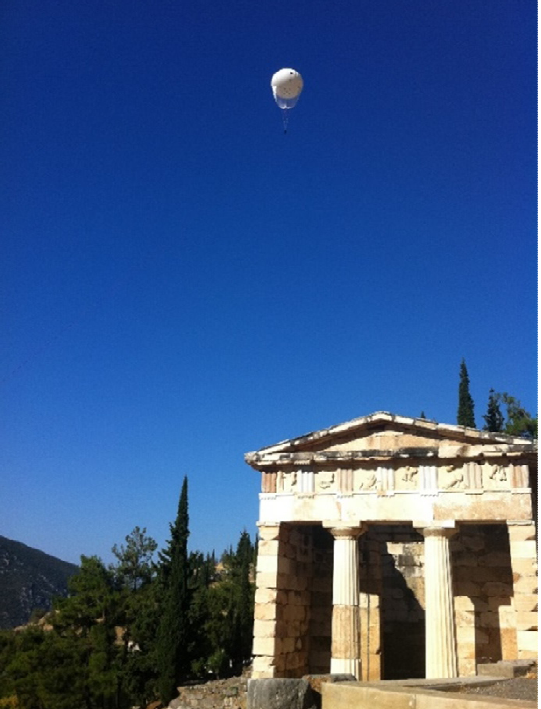
For the creation of the 3D model of Delphi’s archaeological site, more than 13,000 photos were taken, and the model produced by the laboratory of the University UCSD (University of California, San Diego, CA, USA) partner in Delphi4Delphi, had size ~ 4 GB. The 3D model was then simplified, and the final model was used in our Virtual Tour ap- Figure 2. The helium-filled balloon for aerial photography (Kingfisher Aerostat) (© I.Liritzis 2016). plication (Figure 3).